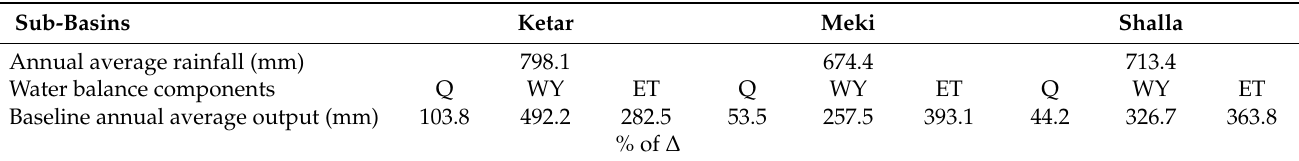
Table 8. The simulated mean annual changes, as a percentage, from the annual average values of the baseline outputs for the major components of the water balance in the